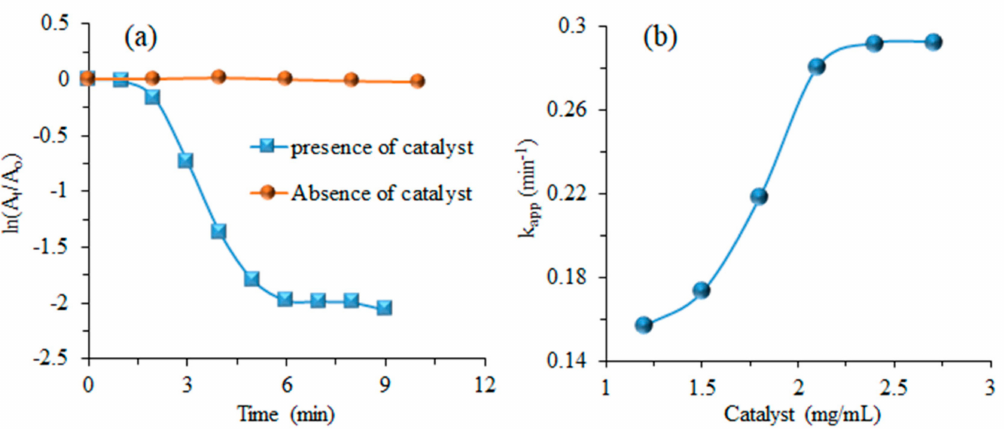
Figure 8. ( a ) Plot of ln(A t / A o ) vs. time and ( b ) plot of catalyst dose vs. k app for reduction of CR [conditions: CR = 0.045 mM, NaBH 4 = 7.88 mM] at room